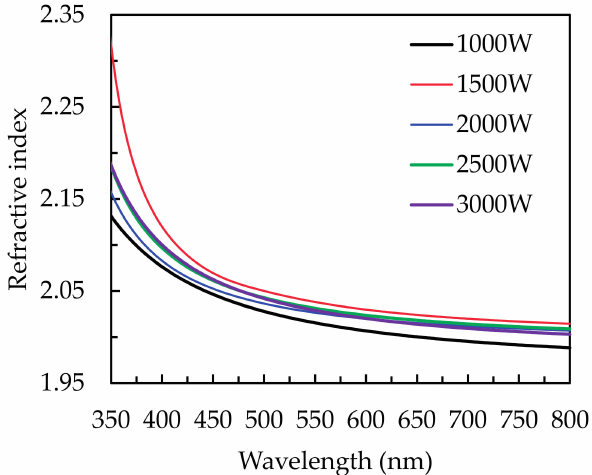
Figure 6. The wavelength-dependent refractive index ( n ) of the PEALD SnO 2 thin films deposited at different plasma power from 1000 to 3000